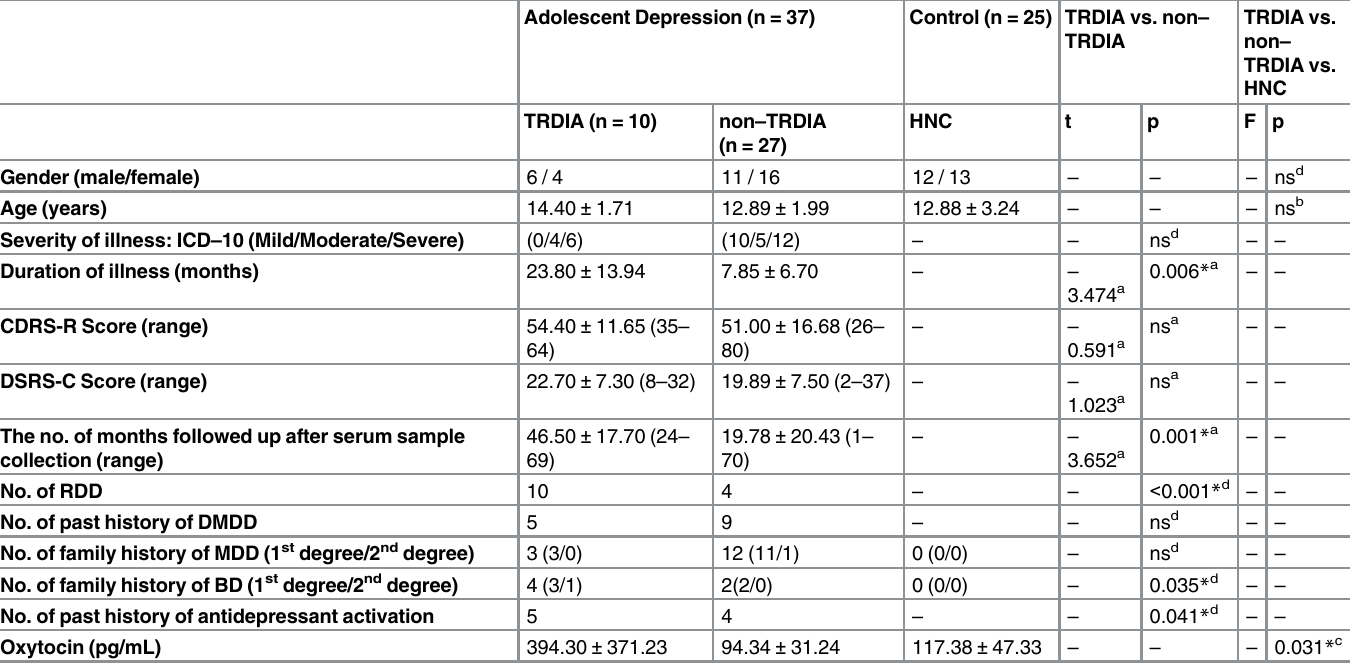
Table 1. Demographic Characterization of Adolescent Patients with TRDIA or non-TRDIA and Normal Controls.